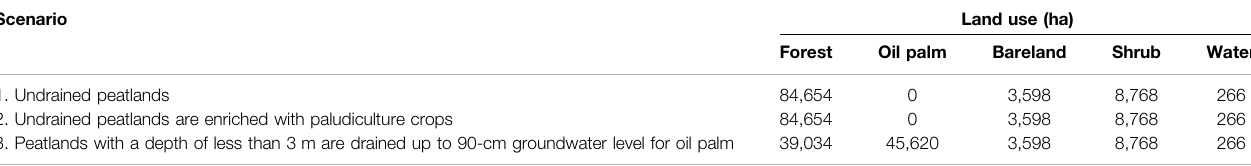
TABLE 1 | Land-use proportion and drainage conditions for each scenario.